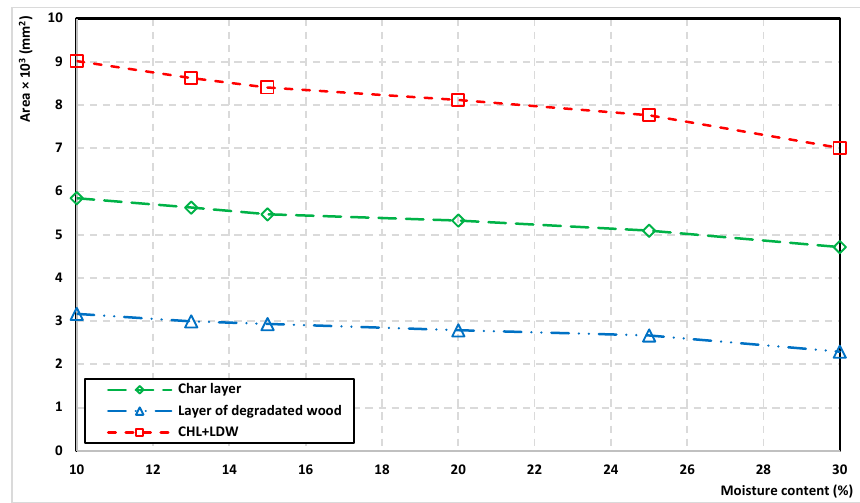
Figure 9. The degradation of wood vs. moisture content.